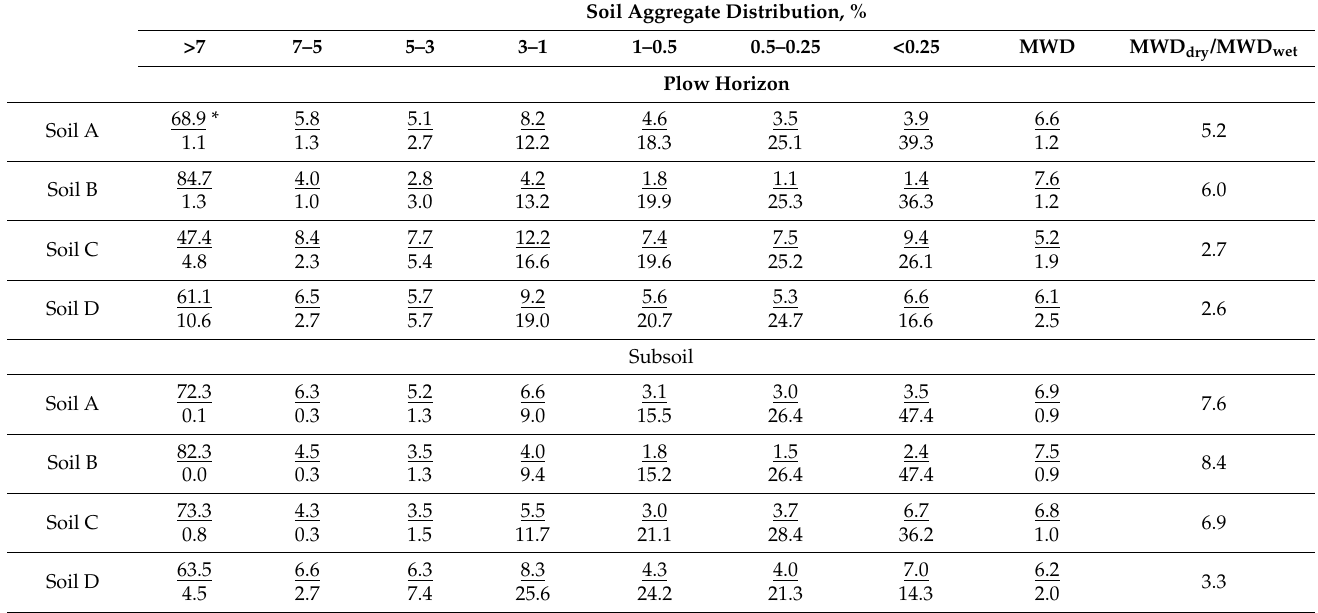
Table 2. Soil aggregate distribution in the plow and subsoil layers of the soils under study (mean values,